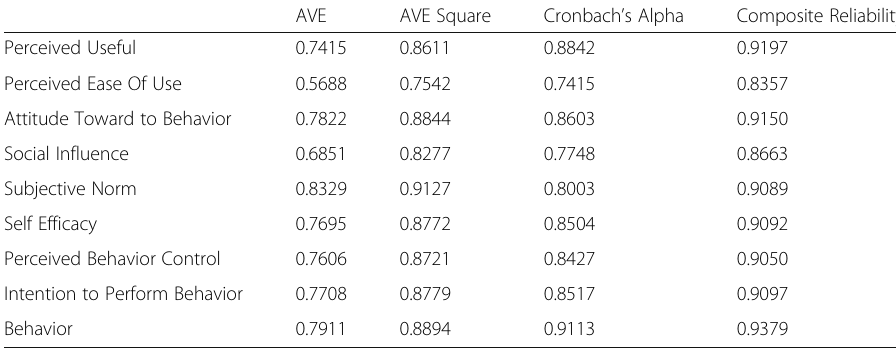
Table 1 AVE, Cronbach ’ s Alpha and composite reliability